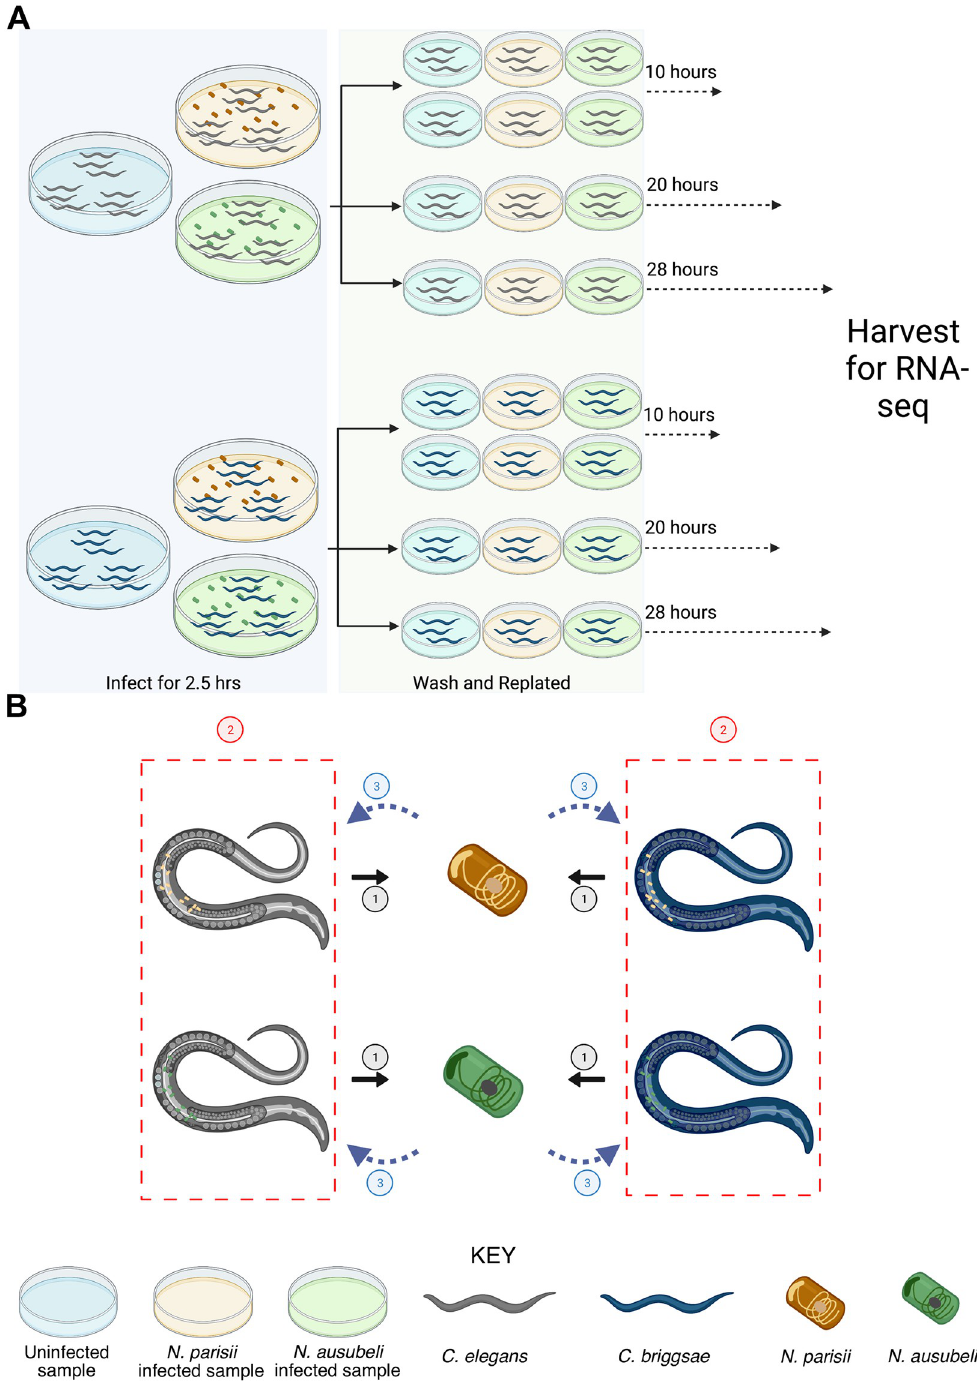
Fig 1. Overview of study design. (A) Schematic diagram of the RNA-seq experiment. C . elegans and C . briggsae were either not infected or infected with N . parisii or N . ausubeli separately at the L1 stage for 2.5 hours. Next, animals were washed to remove any remaining microsporidia spores and replated. Worms were harvested for RNA-sequencing at 10, 20 and 28 hours after infection. (B) The three comparisons of transcriptional responses made in this study are represented. Comparison 1 is microsporidia gene expression between hosts, comparison 2 is the response of each host species to different microsporidia species, and comparison 3 is the conserved response between different hosts to each microsporidia species. Figure was created with BioRender